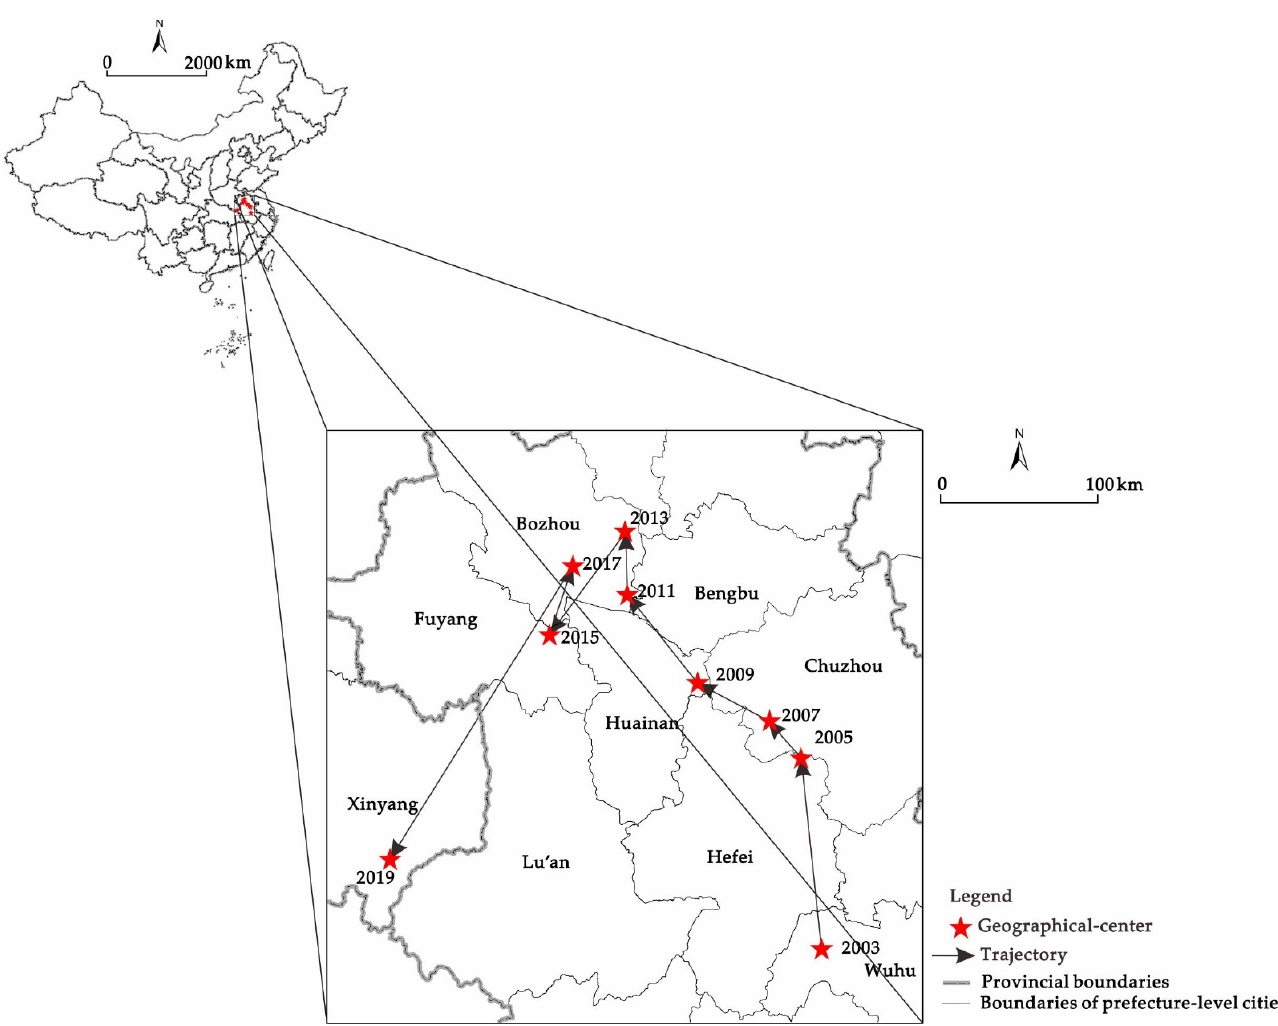
Figure 5. Changes in the geographical center of the spatial distribution of FDI from 2003 to 2019.